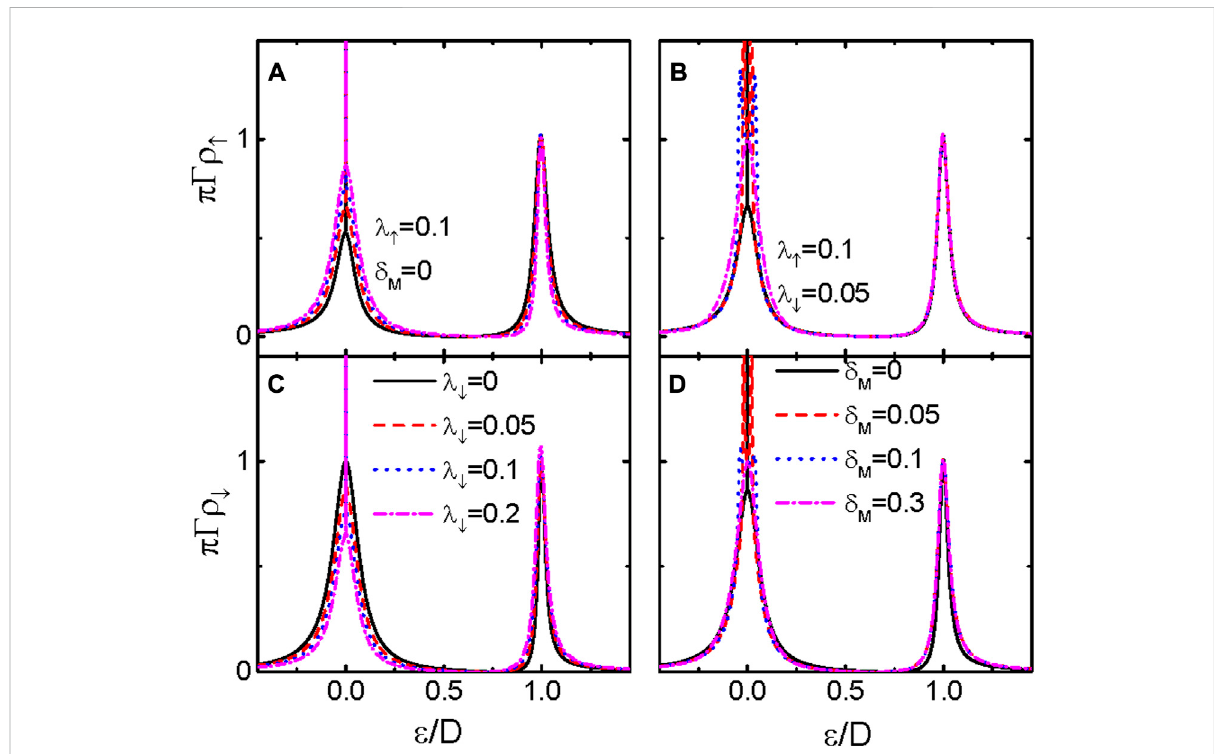
FIGURE 4 (Color online) Spin-up and spin-down LDOS in the presence of intradot Coulomb interaction U = 1 as functions of the electron energy for different values of λ ↓ and δ M = 0 in (A,D) , and λ ↓ = 0.05 and different δ M in (B,C) . The value of λ ↑ is fi xed at 0.1. The other parameters are as in Figure